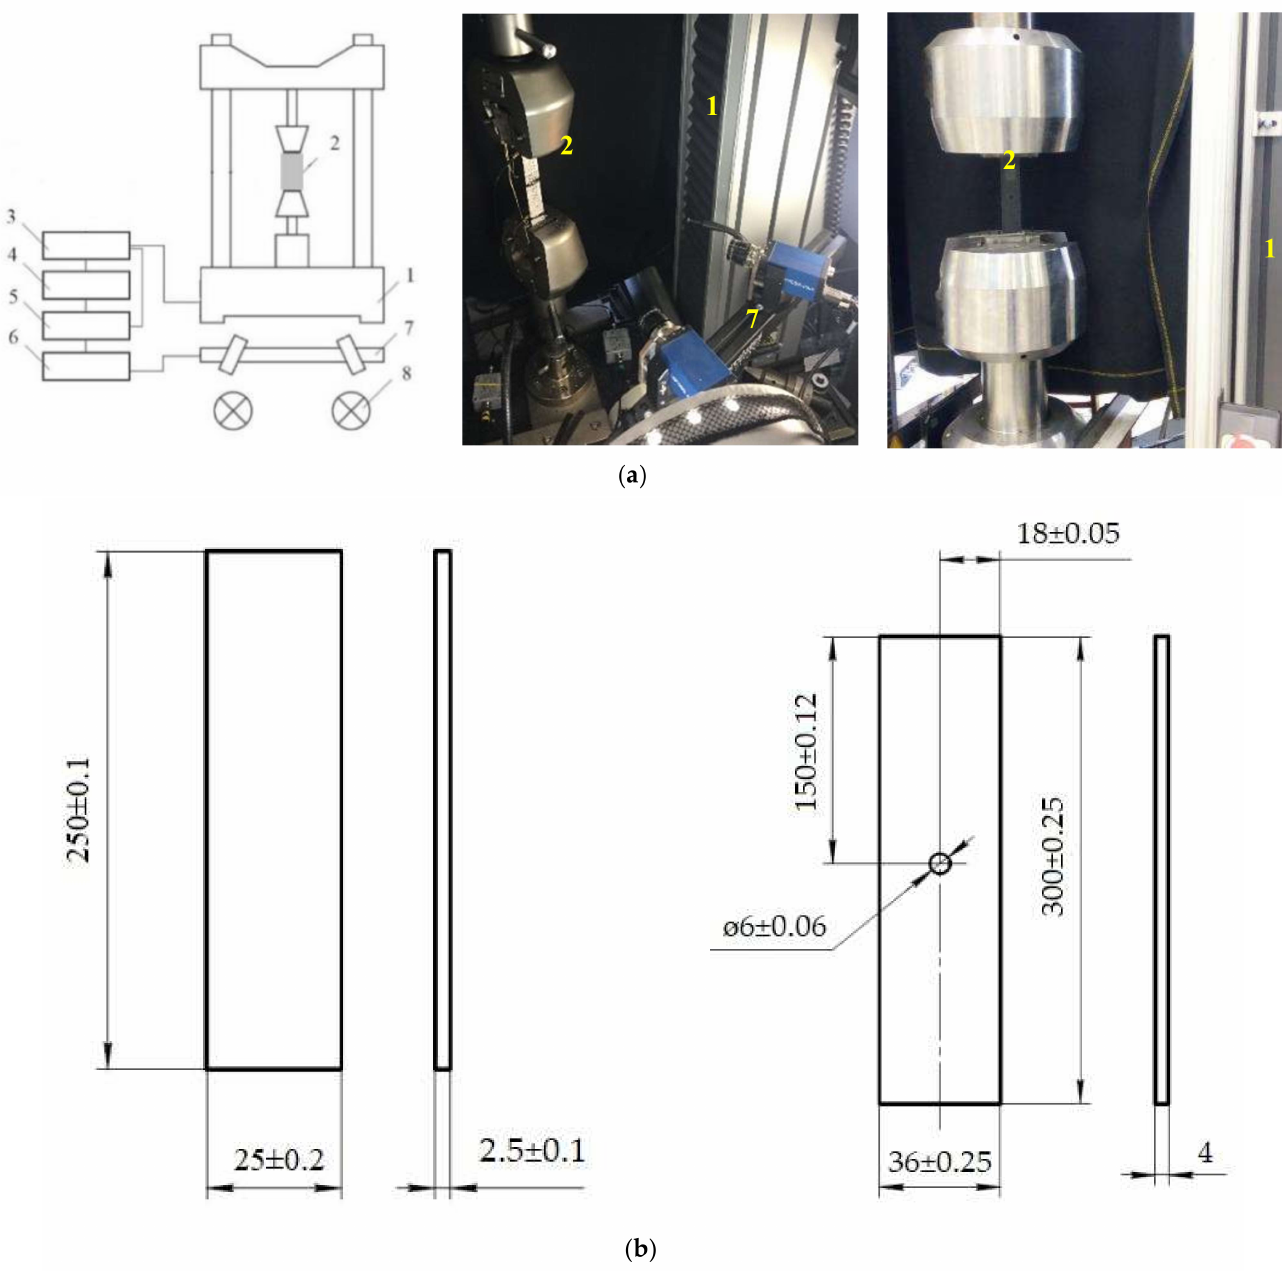
Figure 1. Principled testing scheme for the uniaxial tension of specimens ( a ): 1—test machines, 2—sample installed in the grips, 3—test system controller, 4—PC from which the machine is controlled, 5—synchronization block, 6—PC from which the video system is controlled, 7—cameras installed on tripod, 8—backlight system. Scheme of specimens without an open hole and with an open hole ( b